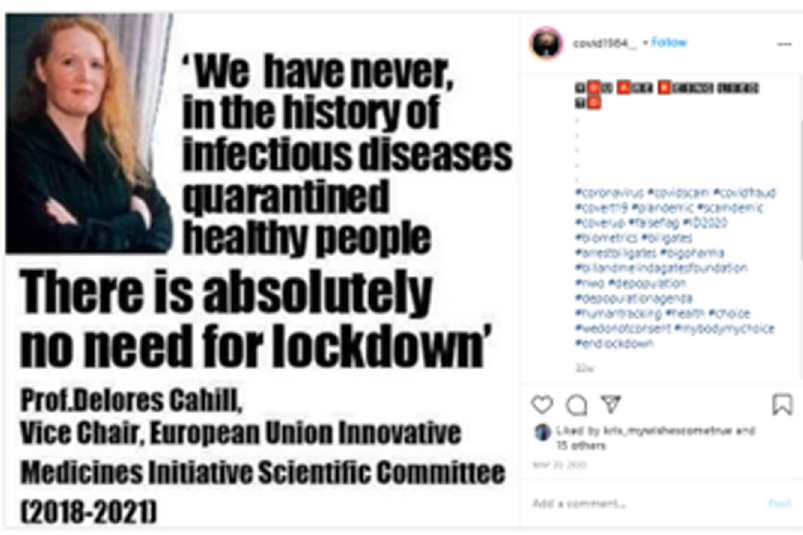
Fig. 5 Instagram post discussing freedom of